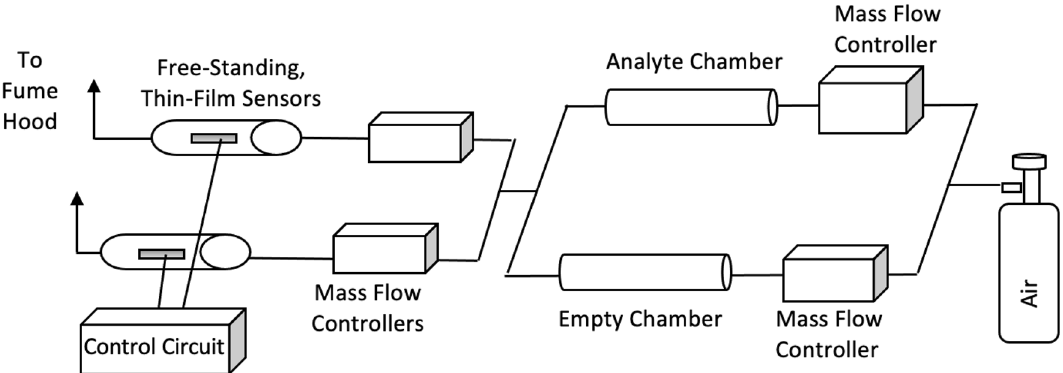
Figure 10. Schematic of apparatus used for testing the free-standing